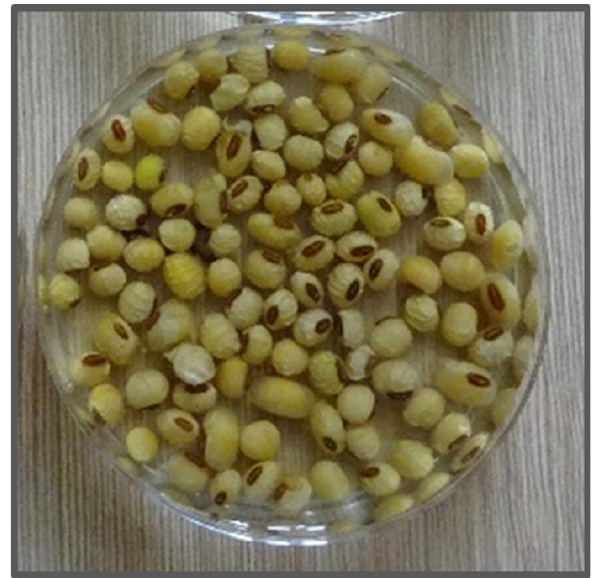
Figure 1: Soaking of soybean seeds with macroalgal extracts.